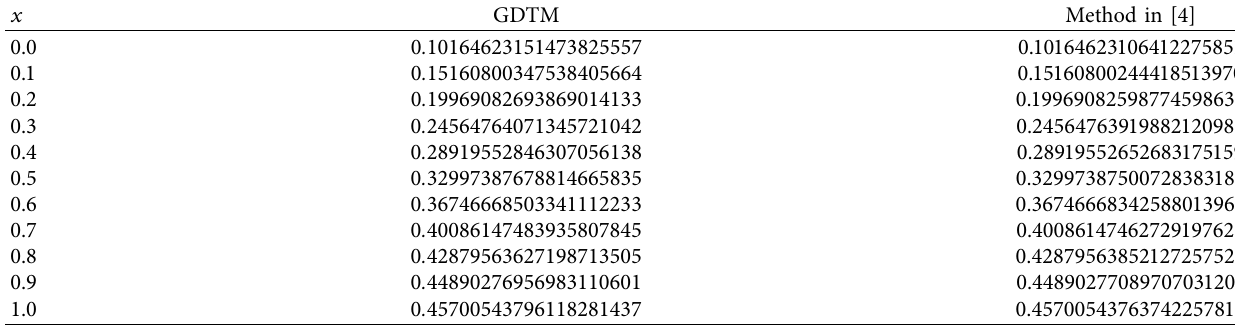
Table 2: Numerical solutions for μ � 0 . 7 , λ � 5 , β � 0 . 8.